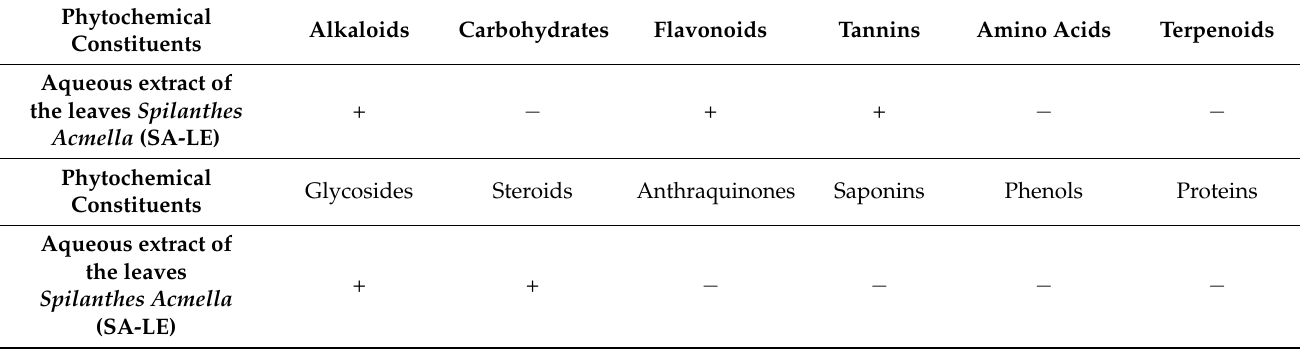
Table 1. Preliminary phytochemical analysis of aqueous extract of the collected